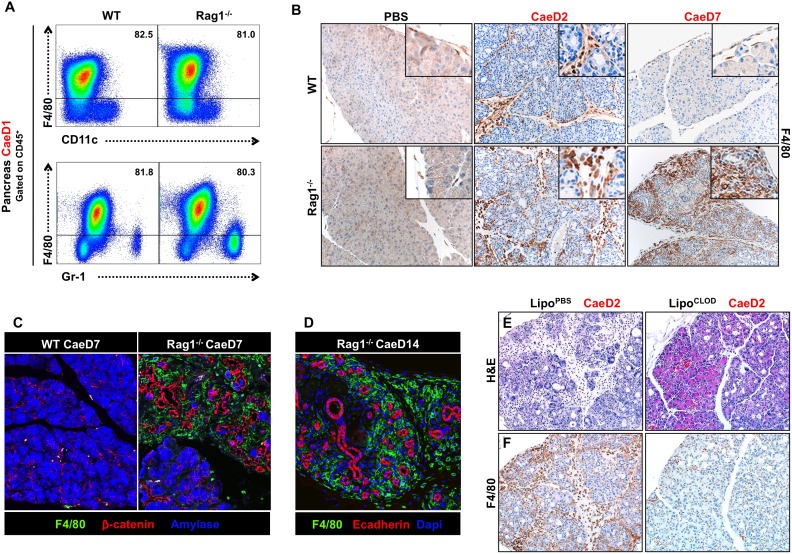
Macrophages are the predominant immune cell infiltrating the pancreas following caerulein-induced injury.(A) Representative FACS plot showing the percentage of CD45+ cells that are F4/80+ compared to F4/80−CD11c+ dendritic cells and F4/80−Gr1+ myeloid cells in the pancreatic immune infiltrate at CaeD1. (B) Immuno-histochemical staining of F4/80+ cells from WT and Rag1−/− treated with PBS or caerulein. (C and D) Immuno-fluorescent staining of the pancreas from WT and Rag1−/− mice showing F4/80+ cells are associated with areas of the de-differentiated epithelium (visualized by β-catenin and Ecadherin) present only in Rag1−/− mice 7-days after caerulein treatment and completely surrounding the lobular epithelium within 14-days. (E and F) Representative H&E and corresponding areas stained with F4/80 from the pancreas of Rag1−/− mice treated with liposomes filled with either PBS or clodronate during caerulein treatment and harvested 2-days after the last caerulein injection.